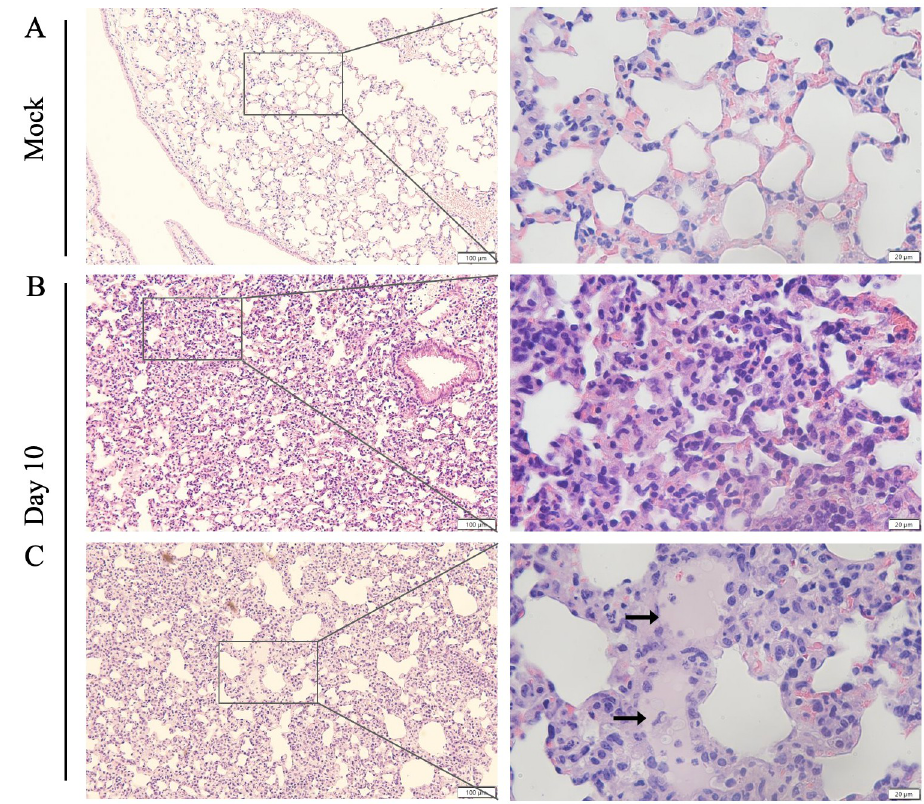
Fig 3. Cellular infiltration and tissue injury in O . tsutsugamushi- infected CD1 mice. CD-1 mice were infected, as described in Fig 1. Lung tissues (3–4 mice/group) were collected from mock ( A ) and at day 10 and subjected to hematoxylin and eosin staining. Cellular infiltration was present with interstitial pneumonia ( B, C ) and pulmonary edema (arrows) observed in the lung tissues of infected mice. Scale bars: 100 μ m and 20 μ m (zoomed).